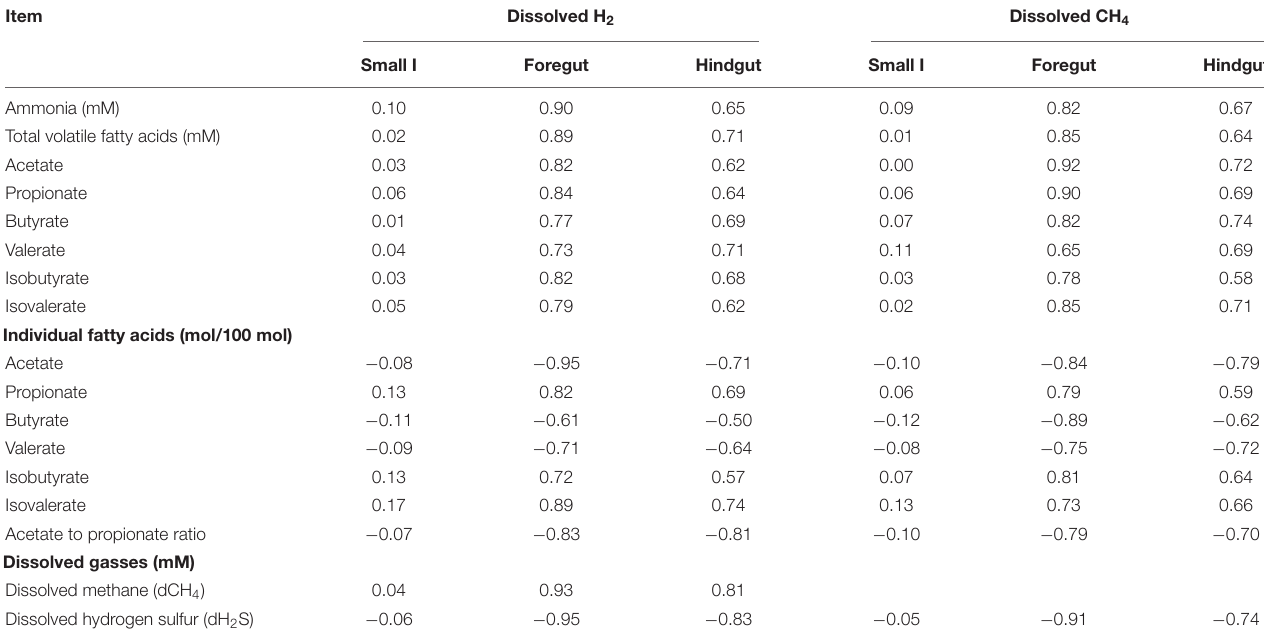
TABLE 5 | Correlation 1 between dissolved hydrogen and fermentation metabolites in the gut regions of goats supplemented with amino